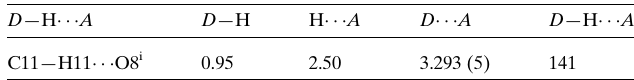
Table 1 Hydrogen-bond geometry (A˚ , (cid:2) ).